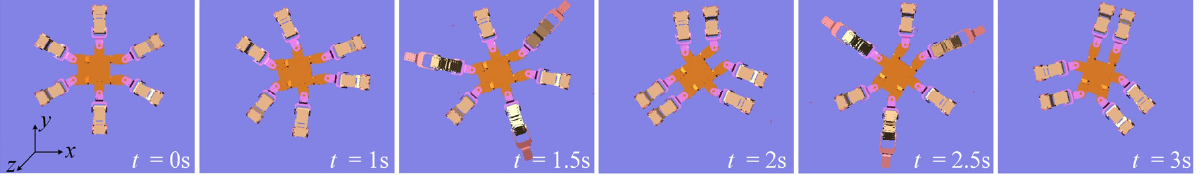
CoMO Figure 11. The stability margin of the wave gait. Based on the definition of a stability margin, the CoM trajectory and the supporting polygon in a single period are shown in Figure 12. In the figure, the lines enveloped by polygons are the CoM trajectories, and the legends indicate the legs in swing phase. It can be seen that the stability margin of the four gaits are always positive in the moving pro ‐ cesses. It means that the stability of the hexapod robot is good, and the hexapod robot is suitable for complex environments.